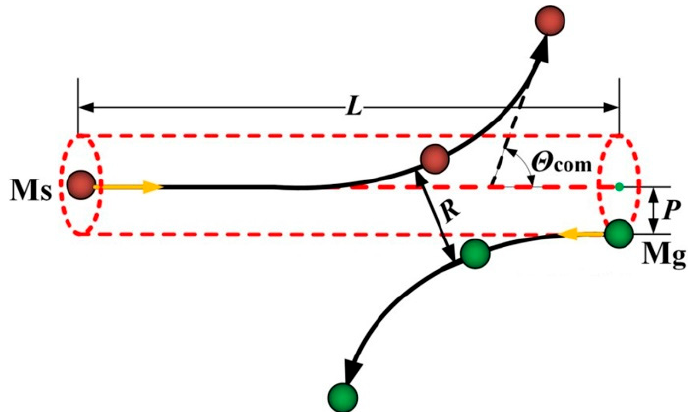
Figure 2. Elastic scattering in the binary collision.